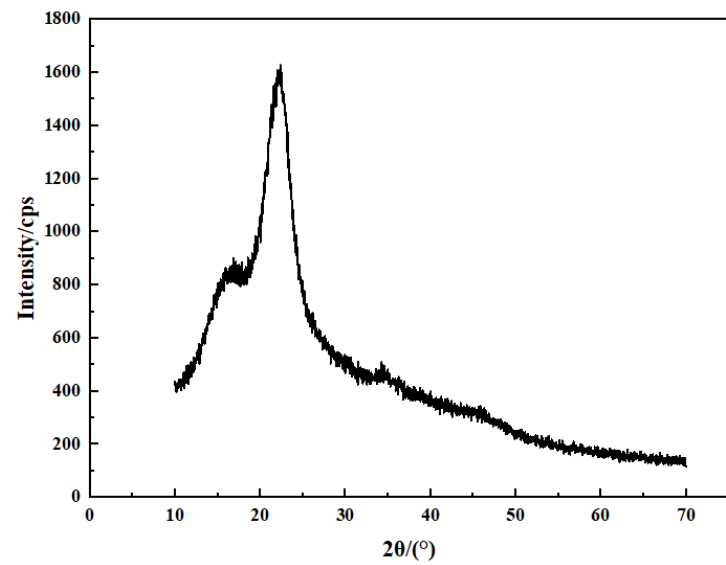
Figure 4. X-ray diffraction pattern of waste hemp fiber.